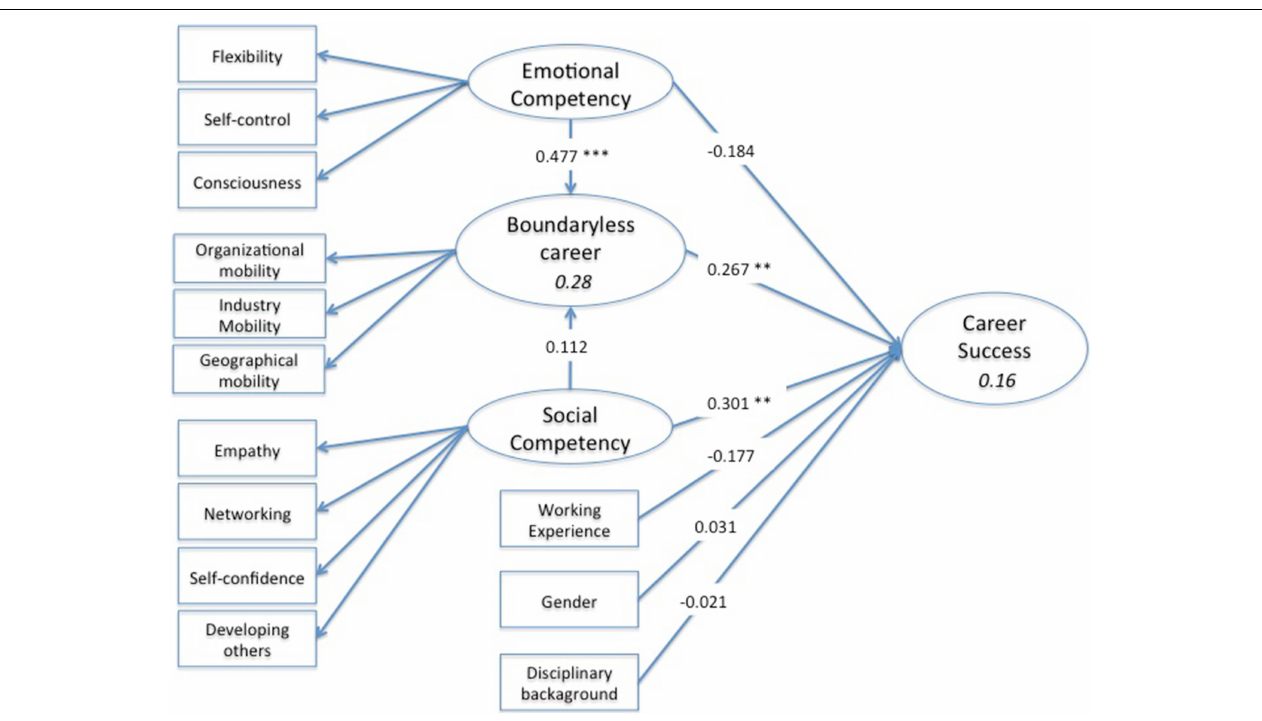
Aroian Mediation